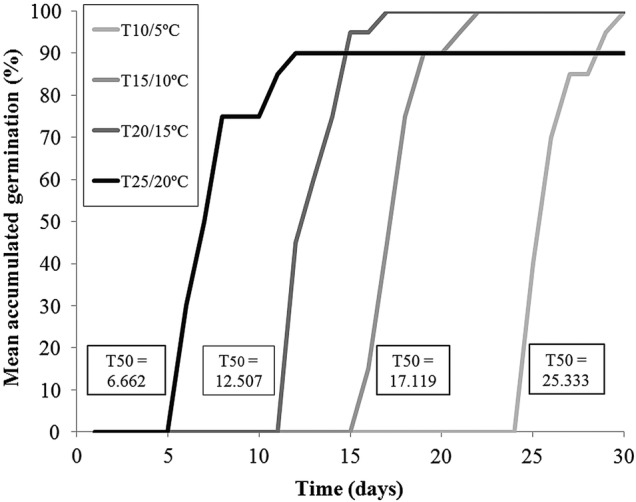
Veronica dabneyi accumulated seed germination curves obtained under 12 h of light and four alternating temperature regimes in Petri dishes in acclimatized chambers, after 30 days. Time for 50 % germination, in days, is shown for each treatment, based on the Gompertz model that was adjusted to each curve (all models with an R2 of >0.9).